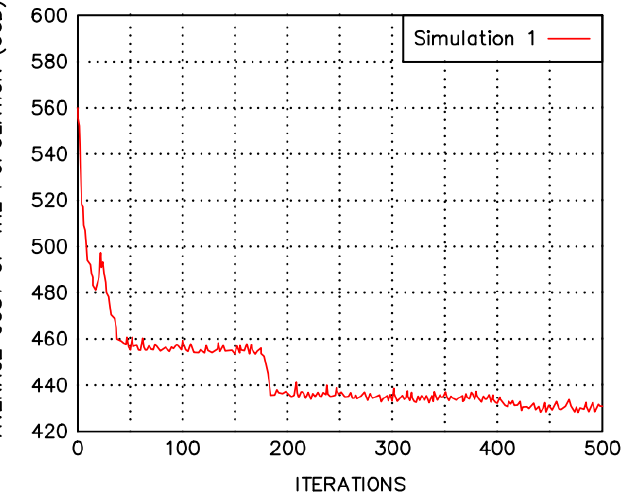
Figure 6. Variation in the mean value of the Fitness Function at each iteration of Simulation 1-2. To finalize and confirm whether it would be possible to find more economical solu- tions than the one found in simulations 1-2, new simulations were performed with the same parameter settings; however, setting 600 and 700 iterations as a stopping criterion. Even providing the GA with more time to escape local optimal points, the results were similar to those of the simulations with 500 iterations, as seen in Figure 7.